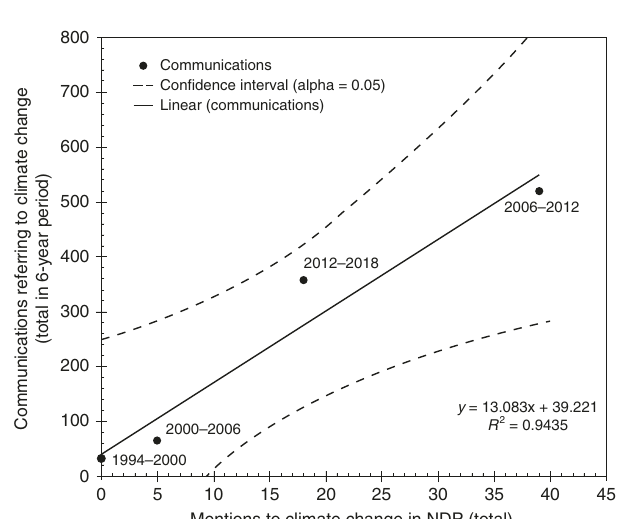
Fig. 3 Relationship between the number of mentions in NDPs and the number of communications made by presidential of fi ces referring to climate change for each presidency of Mexico (1994 – 2018). Data points indicate the total number of mentions and attention levels paid to climate change in the planning and the implementation of the governmental agendas in the corresponding 6-year periods; regression con fi dence interval for 95%